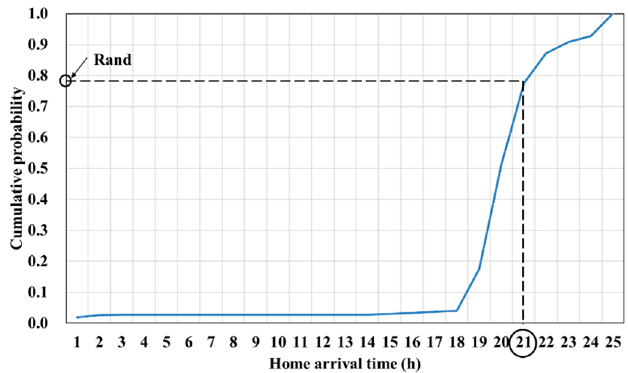
Figure 5. Stochastic method to model the plug ‐ in time.